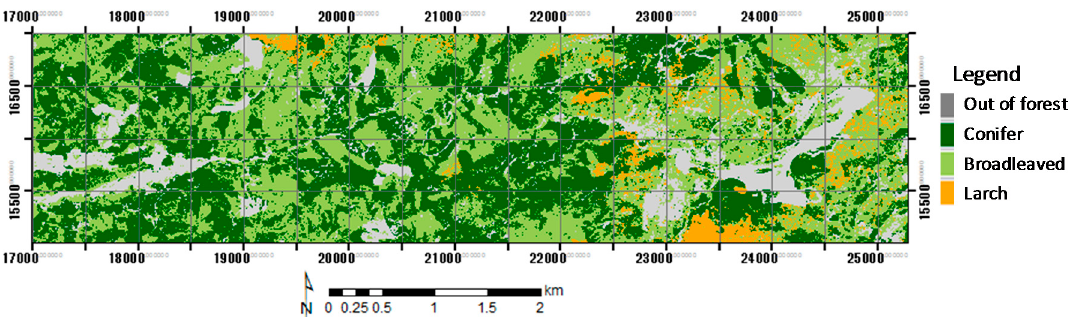
Figure 3. Forest type map of the mapping area.